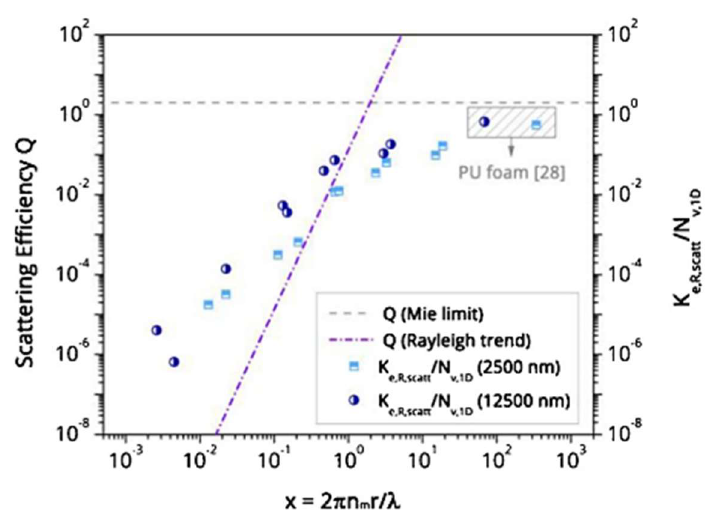
Figure 6. Right axis: Scattering efficiency Q for a Rayleigh-like behaviour and Mie limit as a function of the size parameter x . Left axis: Scattering extinction coefficient normalized by the 1D cell density as a function of the size parameter x. (Reprinted with permission from Ref. [101], Copyright © 2020, Elsevier).